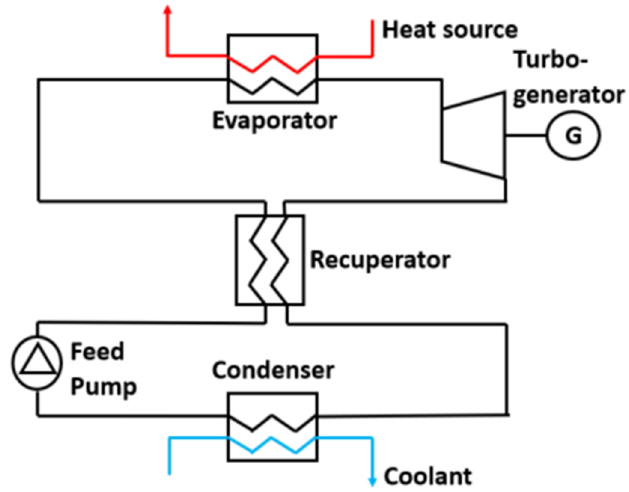
Figure 12. Recuperative ORC cycle configuration (rcORC).